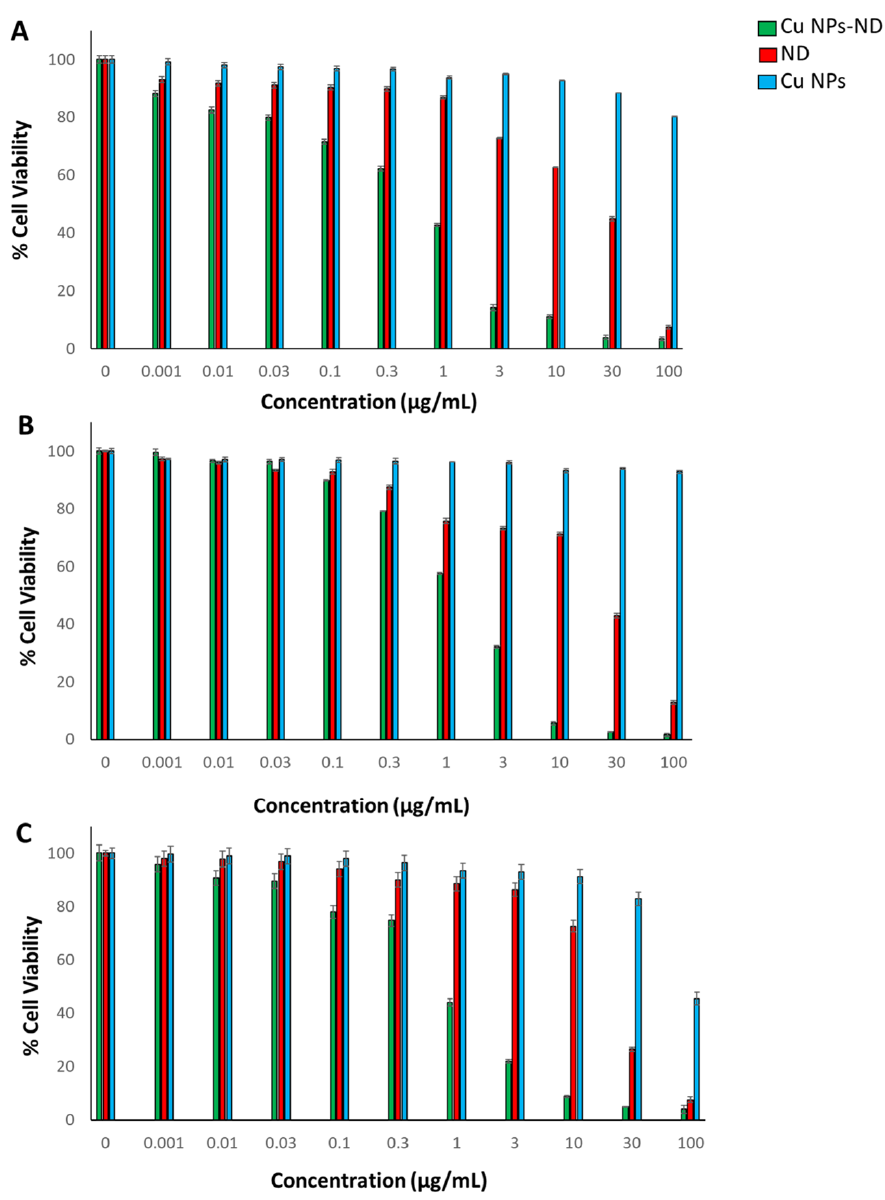
Figure 4. Percent cell viability of ( A ) HEP-G2, ( B ) MCF-7, and ( C ) SKOV-3 cell lines. All the experiments were carried out in triplicate with mean values presented and error bars represent ± standard deviation.